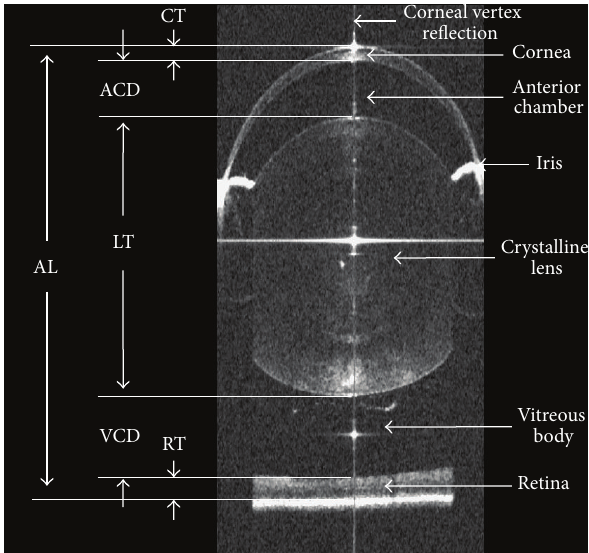
Figure 4: The schematic diagram of axial length measurement from the anterior corneal surface to the retinal pigment epithelium along the corneal vertex reflection.